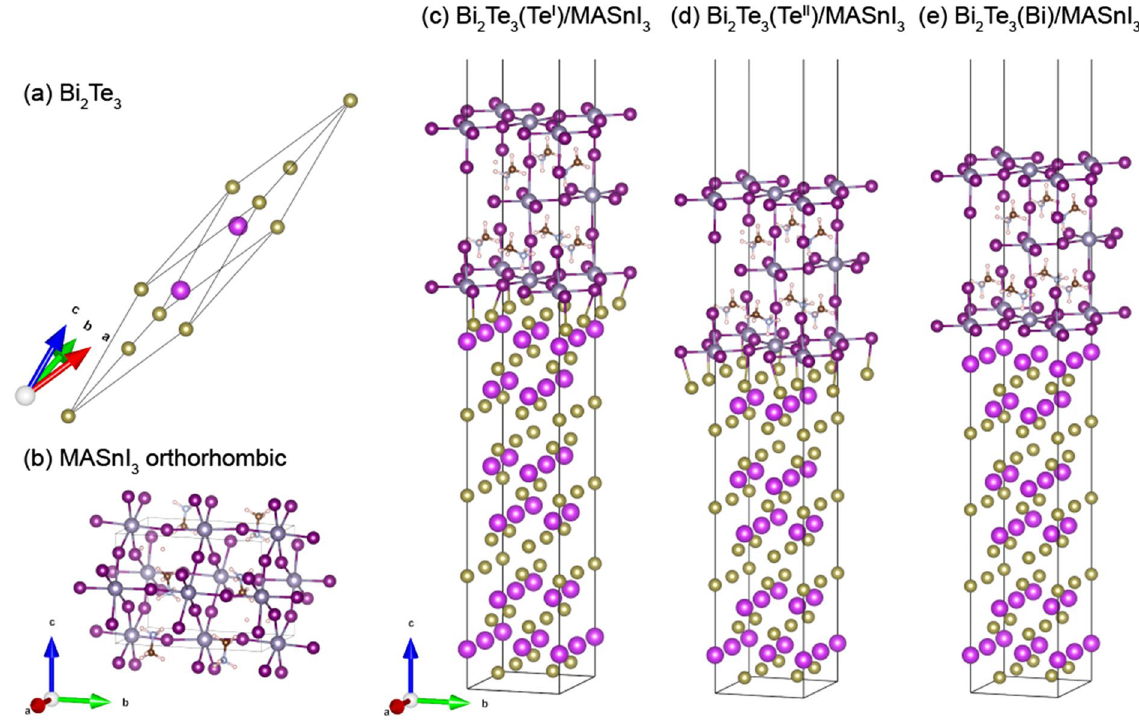
Figure 1. Structural models of ( a ) Bi 2 Te 3 and ( b ) orthorhombic MASnI 3 used for the DMM calculation; calculated interface structures of ( c ) Bi 2 Te 3 (Te I )/MASnI 3 , ( d ) Bi 2 Te 3 (Te II )/MASnI 3 , and ( e ) Bi 2 Te 3 (Bi)/MASnI 3 . The interface crystal plane is (001). The (001) crystal plane was used for both Bi 2 Te 3 and MASnI 3 , with an ~ 15 Å vacuum layer